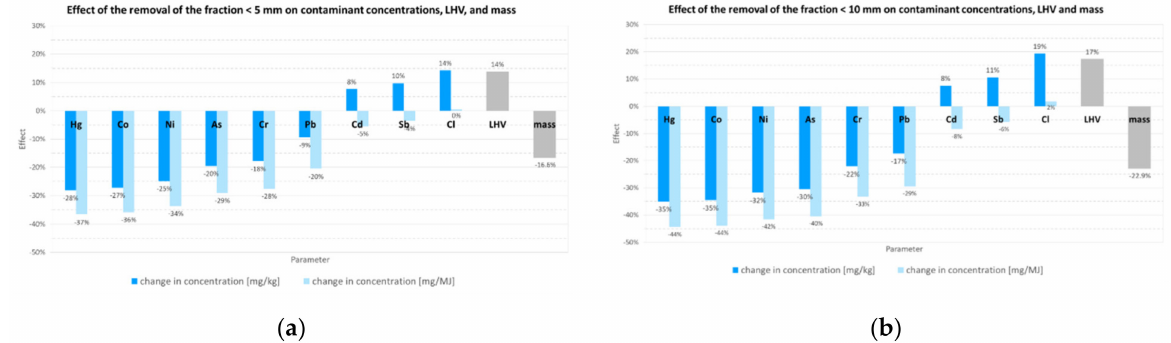
Figure 8. Effect of the removal of the fine fraction <5 mm ( a ) and <10 mm ( b ) on analyte concentrations in mg/kg DM and mg/MJ